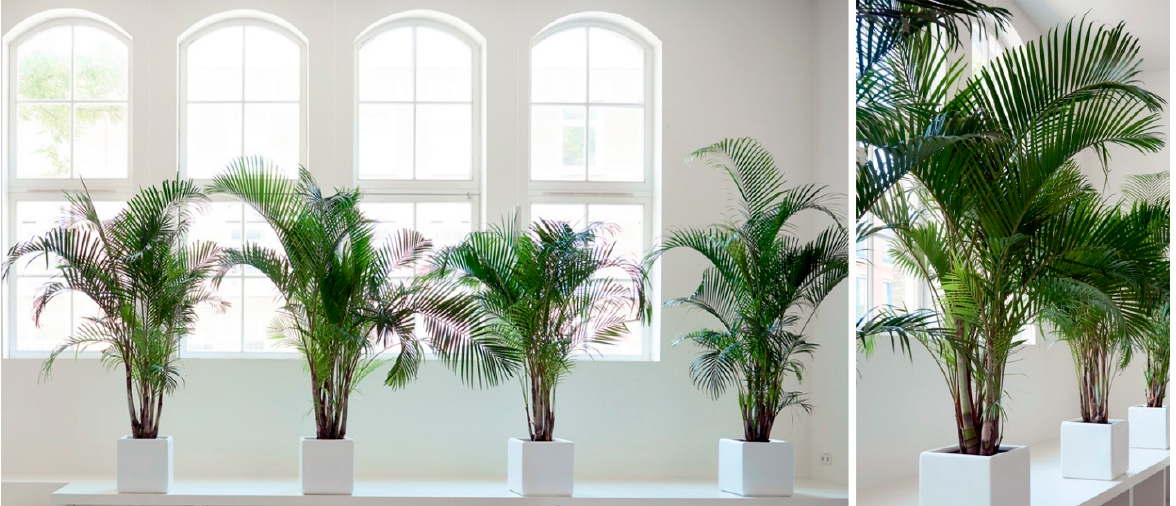
Figure 3. The target plant, the areca palm tree. Table 1. O 2 and CO 2 concentrations for different air purification